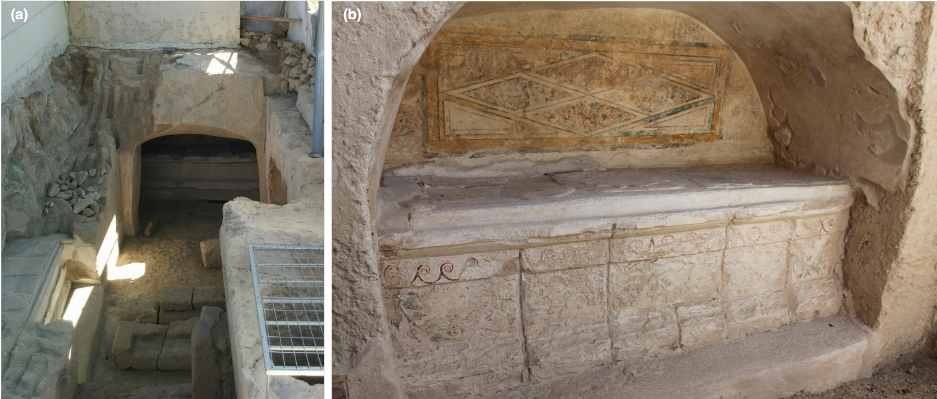
Figure 2. ( a ) Tomb 3882, uncovered and partially damaged during a modern-day construction project. The southeast arcosolium ( b ) located on the right, where a painting of interest for this study is located, is a confined space. The limited physical access to the tympanum, the care needed to operate around the surrounding decoration on the dado level, and the lack of electrical power create a significant engineering challenge for bringing in and configuring large/heavy instrumentation to scan the